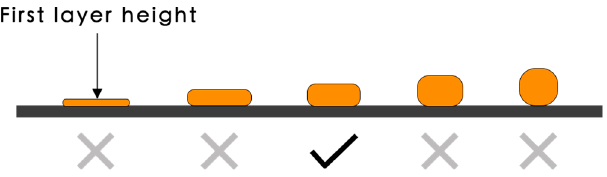
Figure 6. The optimum nozzle height and first layer width.